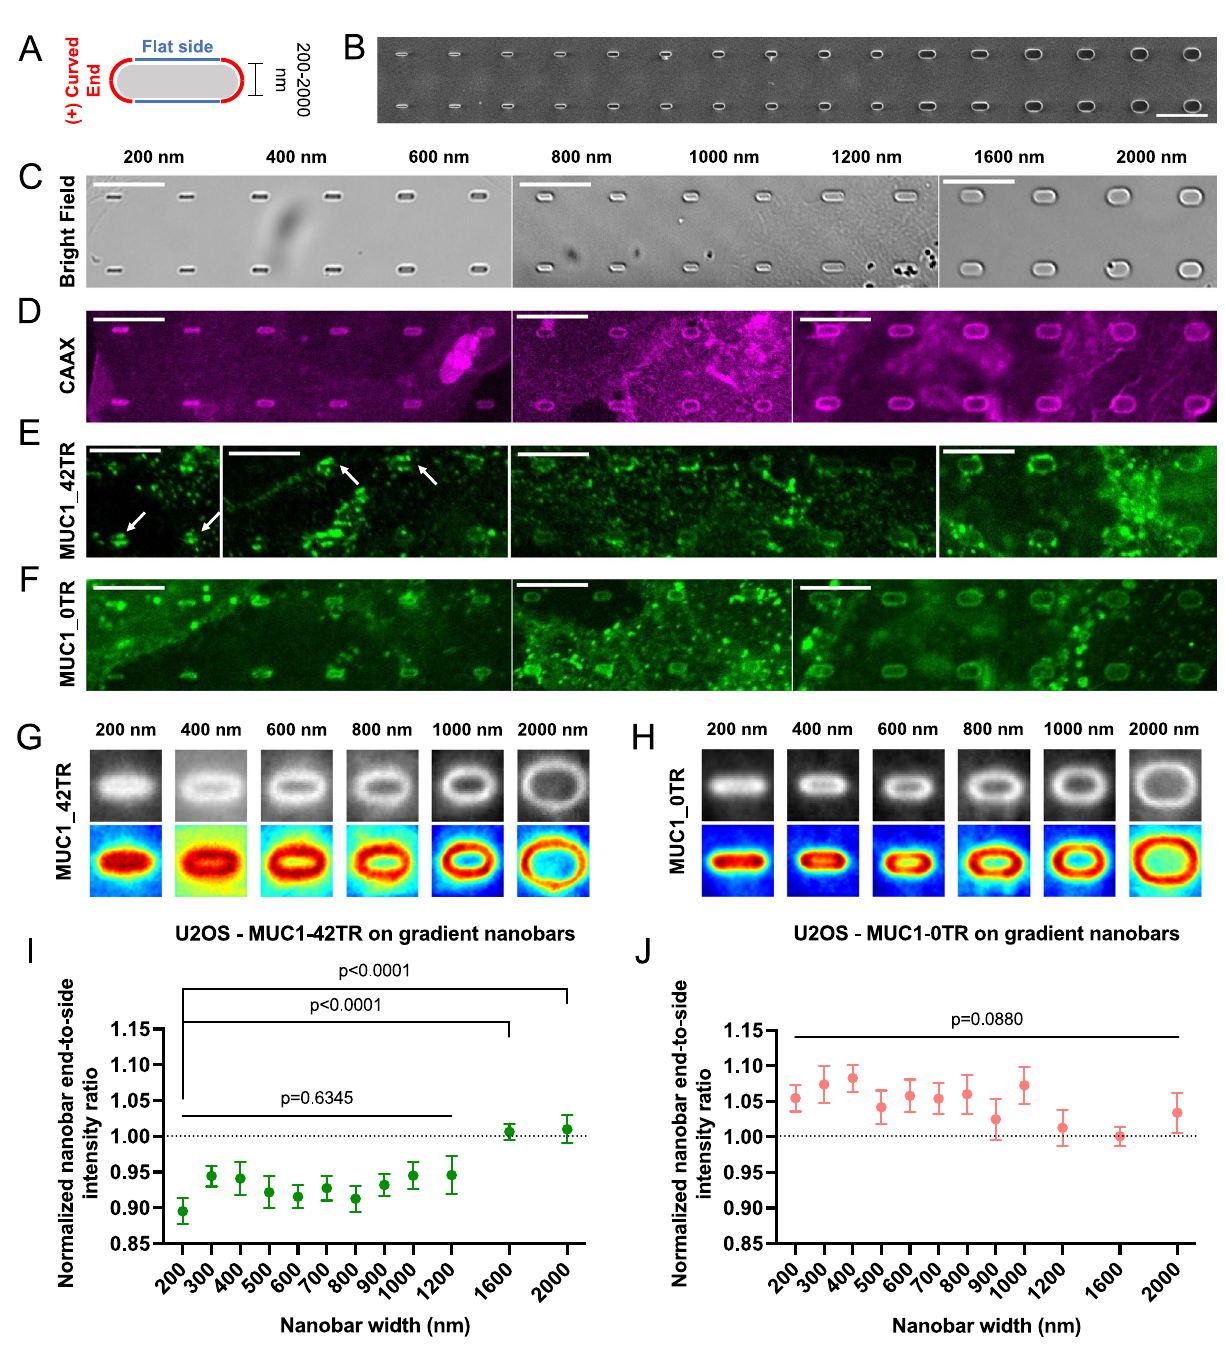
Fig. 7 MUC1 ’ s avoidance of positively-curved membranes depends on the curvature value. A Schematic illustration of a nanobar inducing both fl at and positive curvature. B A SEM image and C bright- fi eld images of gradient nanobar arrays with widths ranging from 200 (left) to 2000 nm (right). All nanobars are 1 µ m in height and 5 µ m in spacing. Nanobar width increment: 200 nm for the nanobars smaller than 1200-nm ones and 400 nm for the nanobars larger than 1200-nm ones. D – F Confocal images of U2OS cells expressing ( D ) mCherry-CAAX, ( E ) MUC1_42TR-GFP, and ( F ) MUC1_0TR-GFP cultured on the gradient nanobar arrays. G , H Averaged fl uorescence images and heatmaps show the spatial distributions of G MUC1_42TR-GFP and H MUC1_0TR-GFP on the gradient nanobar arrays of six selected widths. I , J Quanti fi cation of I MUC1_42TR-GFP and J MUC1_0TR-GFP on the gradient nanobar arrays (see Supplementary Table 7 for the detailed statistics). All ratios are normalized against the mCherry-CAAX signals. Scale bars = 10 µ m for all images in this fi gure. Error bars represent SEM. Both Welch ’ s t -tests (unpaired, two-tailed, not assuming equal variance) and one-way Welch ’ s ANOVA are applied for the statistical analyses in this fi